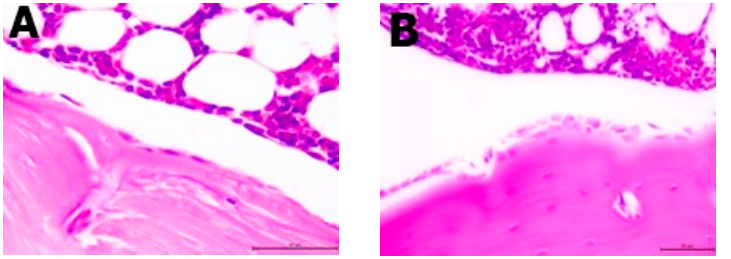
Figure 2. The levels of adipokines and cytokines in the adipose tissue of rats. OVX: ovariectomized group; OVX-D: ovariectomized group with a deprivation of calcium; OVX-CL: ovariectomized group with a deprivation of calcium with the addition of calcium lactate; OVX-PCL: ovariectomized group with a deprivation of calcium with the addition of pumpkin enriched with calcium lactate. IL-31: interleukin 31; IL-33: interleukin 33.